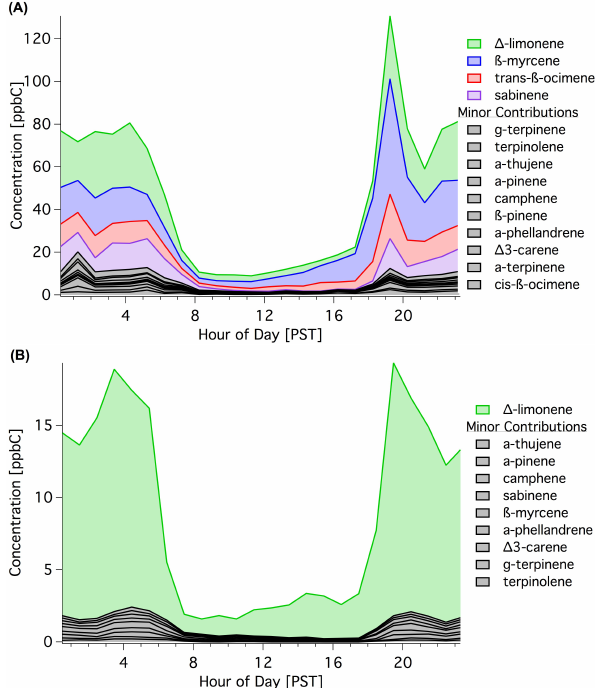
Figure 4. Diurnal pattern and composition of monoterpenes in (A) spring during flowering and in (B) summer.